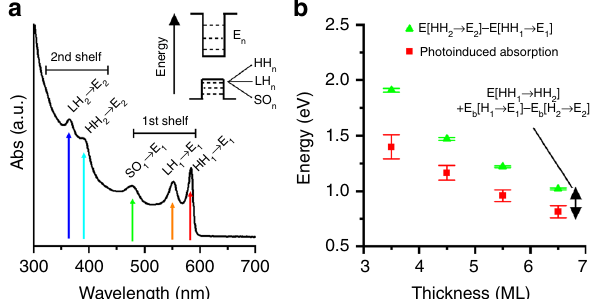
Fig. 2 Electronic structure and optical properties of colloidal quantum wells. a Absorption spectrum of a 6.5 ML CQW with speci fi c interband absorption resonances labeled according to the inset cartoon band diagram. b Thickness-dependent energies, in green circles, of the energy experimental difference between energy E HH 2 ! E 2 ½ (cid:2) and the energy E HH ! E ½ (cid:2) of the n = 2 and n = 1 interband transitions, determined from 2 1 optical absorption spectra. Transition energies are estimated based on (~1.5 nm). Also plotted in red squares are experimentally observed feature re fl ect the full-width at